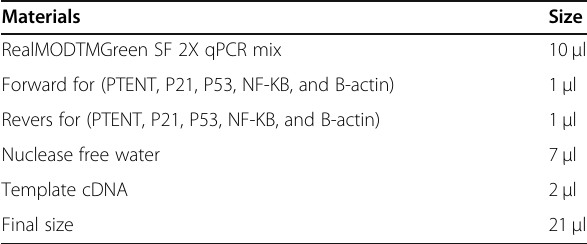
Table 4 Components of real-time PCR reaction